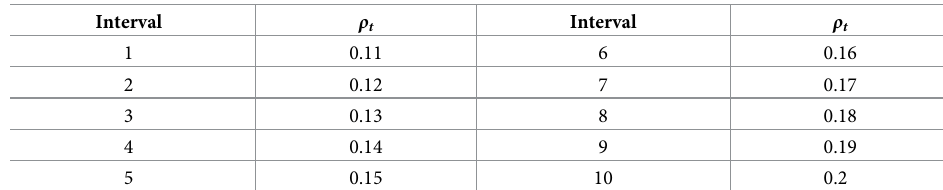
Table 7. ρ in all time t